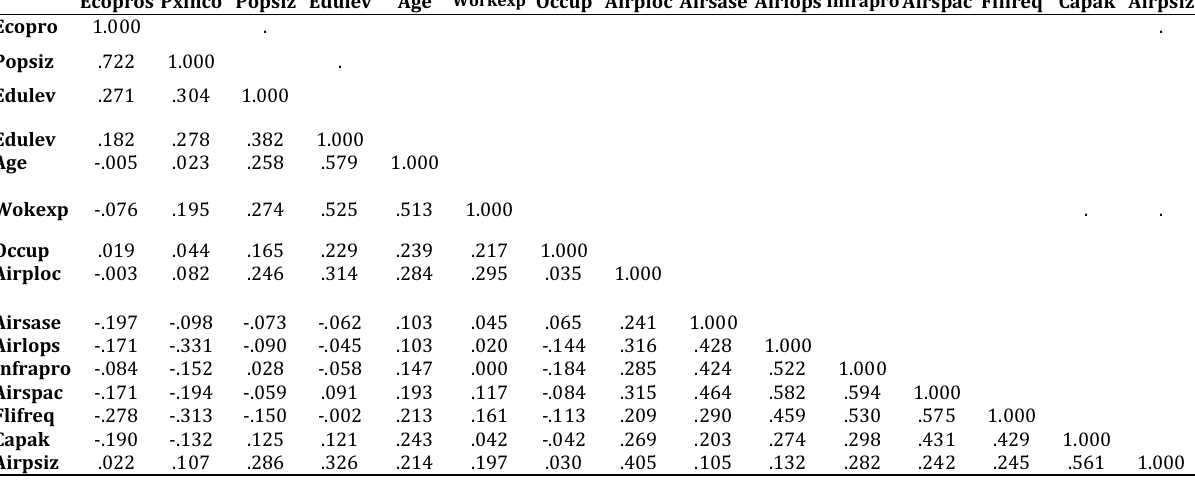
Extraction Method: Principal Axis